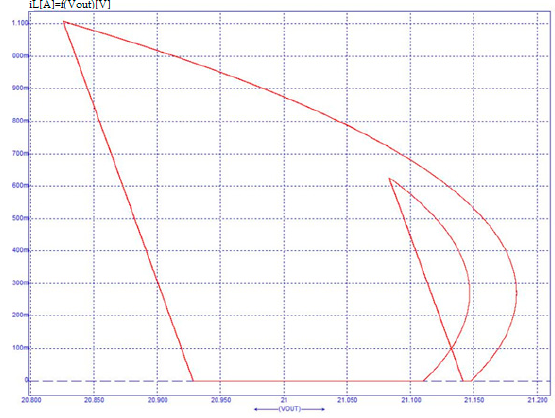
Figure 8. Phase portrait for k = 1.2, higer than 1.1589, confirming period doubling.